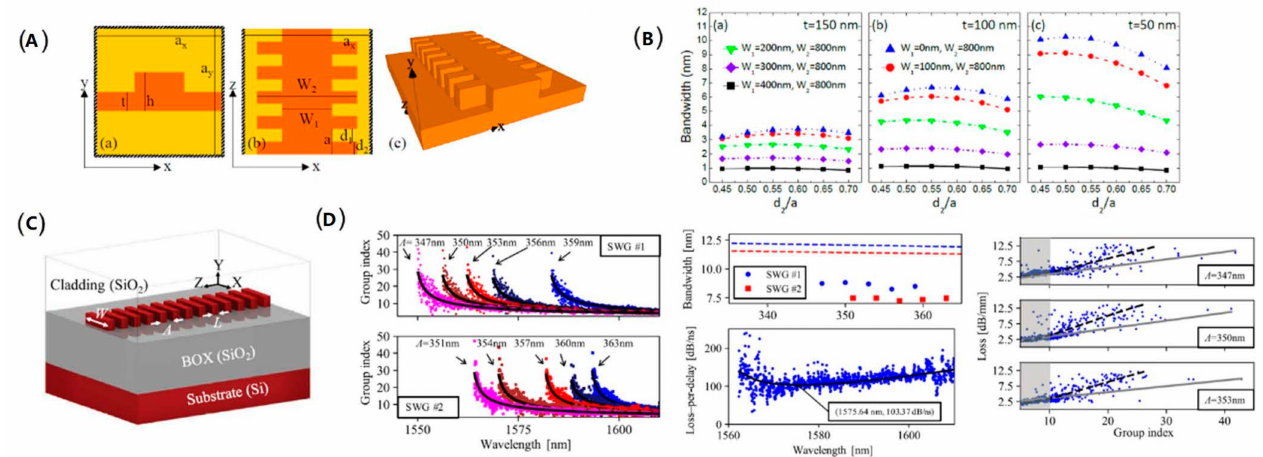
Figure 3. The structure and properties of silicon grating waveguides. ( A ) Cross-section for differ- ent views of the grating waveguide [38]. ( B ) Slow-light bandwidth with different parameters [38]. ( C ) Scheme of the subwavelength grating waveguide on SOI platform [39]. ( D ) Group index, slow-light bandwidth, loss-per-delay figure of merit, and loss of the subwavelength grating waveguides